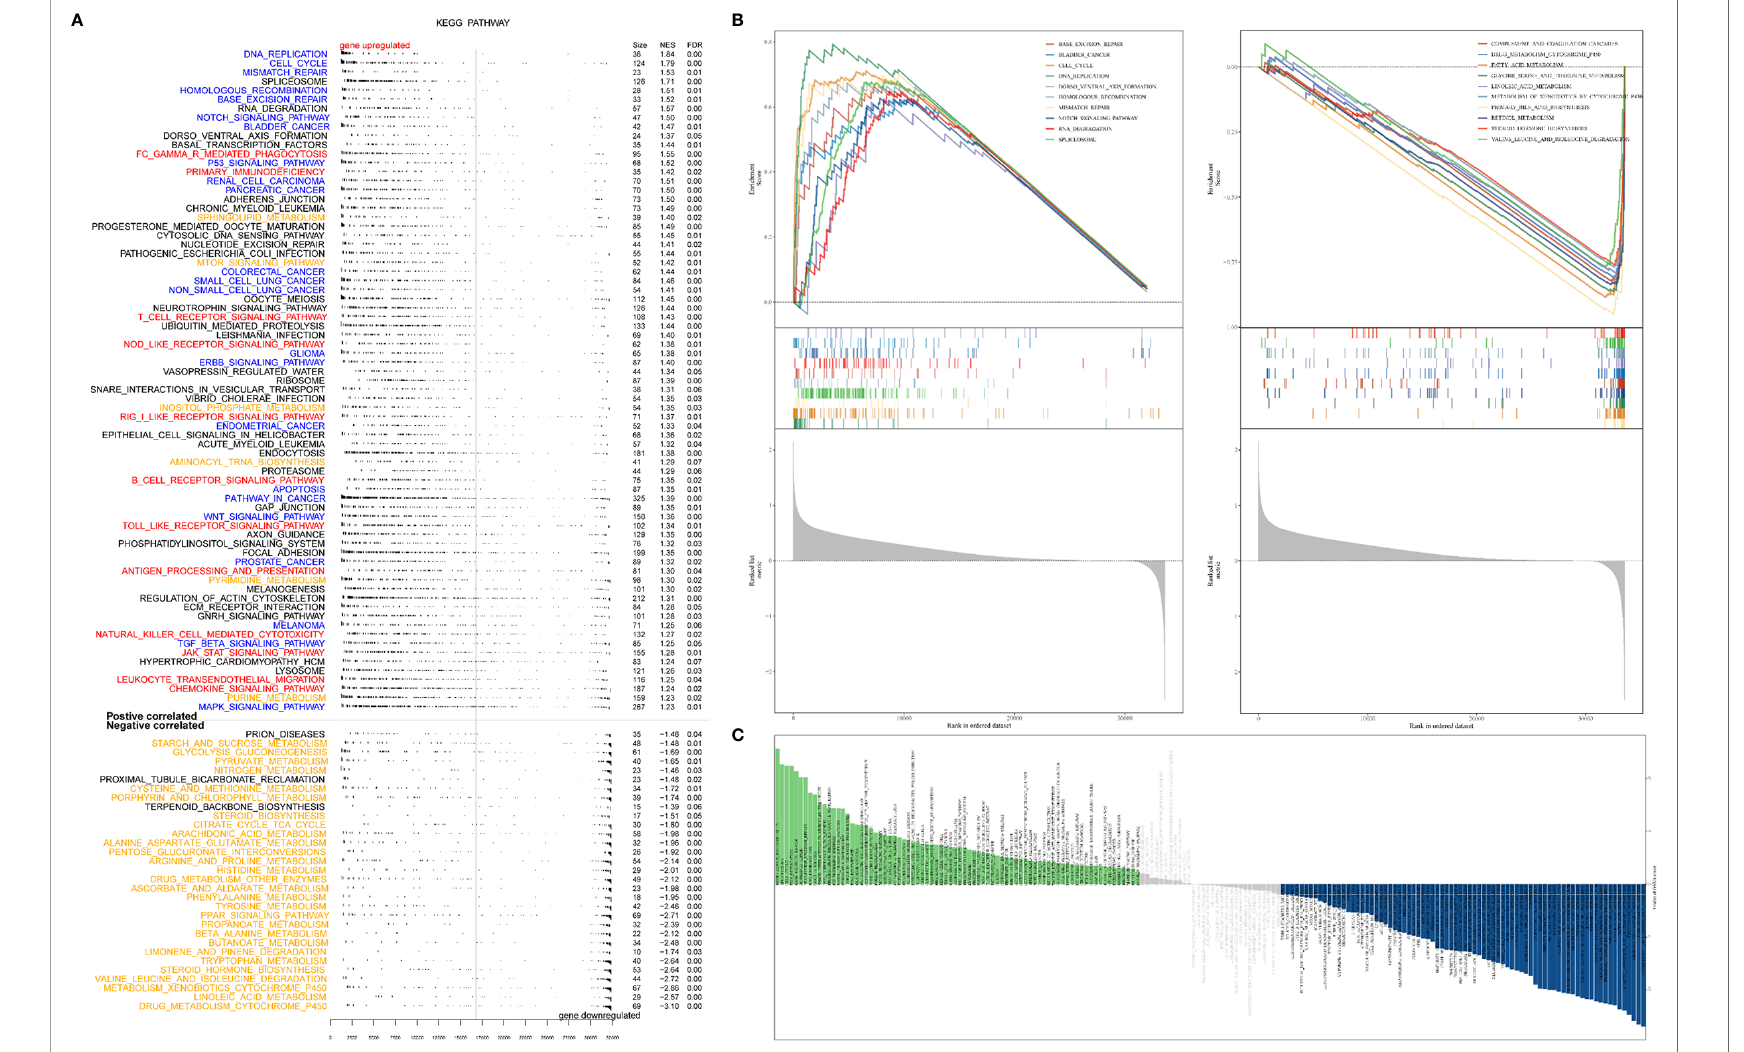
FIGURE 4 | Signal pathways involved in ACYP1. (A) Correlation between ACYP1 expression and KEGG pathways in LIHC analyzed via GSEA. (B) The top ten signaling pathways with signi fi cant positive and negative correlations with ACYP1 in LIHC. (C) Relationships between ACYP1 expression and KEGG pathways in LIHC performed via GSVA (NSE ≥ 1.0,